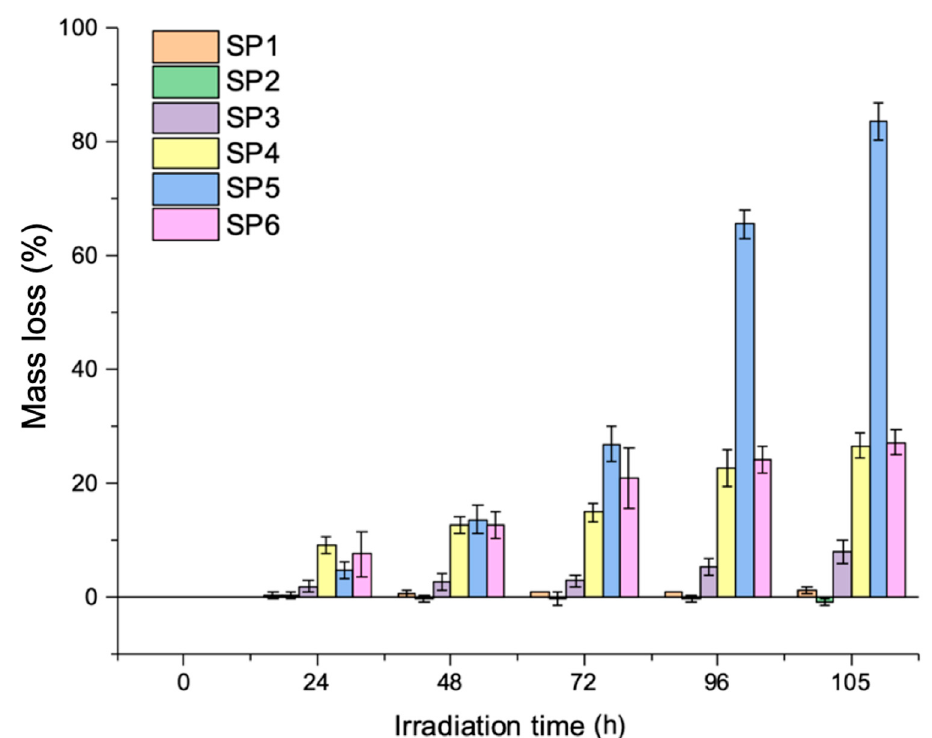
Figure 6. Experiment investigating the degradation of the PA66 microfibres under different conditions of UV and presence of catalyst for 105 h. SP1 = deionised water ; SP2 = deionised water + TiO 2 ; SP3 = deionised water + UVA ; SP4 = deionised water + UVA + TiO 2 ; SP5 = deionised water + UVC ; SP6 = deionised water + UVC + TiO 2 . Error bars = standard deviation of a triplicate study. The average initial mass of the PA66 microfibres used was 1.26 mg.